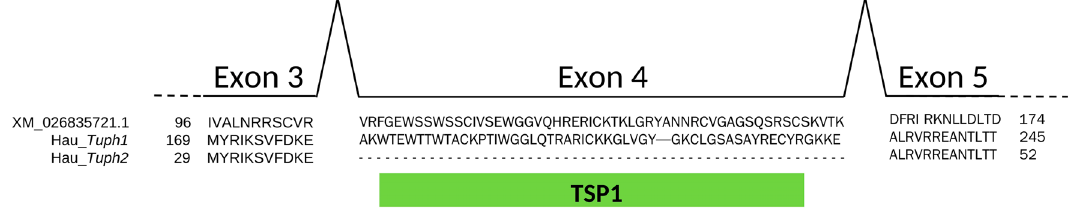
Figure 7. Alignment of C. intestinalis hemocyanin (ncbi ID XM_026835721.1) with translations of two H. aurantium Tuphoxins : Hau_ Tuph1 and Hau_ Tuph2 . Intron positions in chromosome DNA of C. intestinalis is indicated by arches. Position of thrombospondin first type repeat (TSP1) domain is shown by green